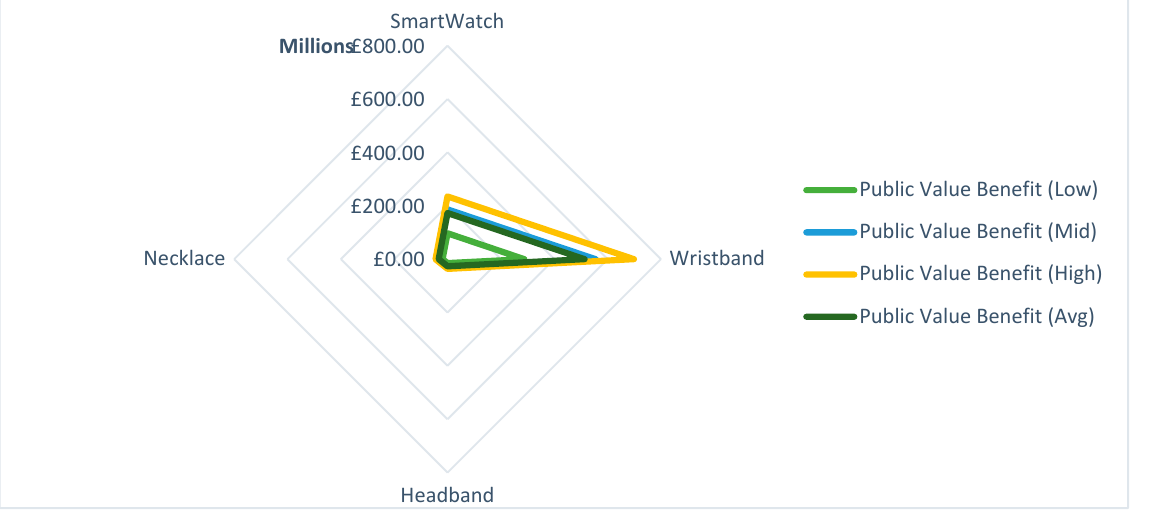
Figure 3. Public value benefit for wearable technologies included within this review.